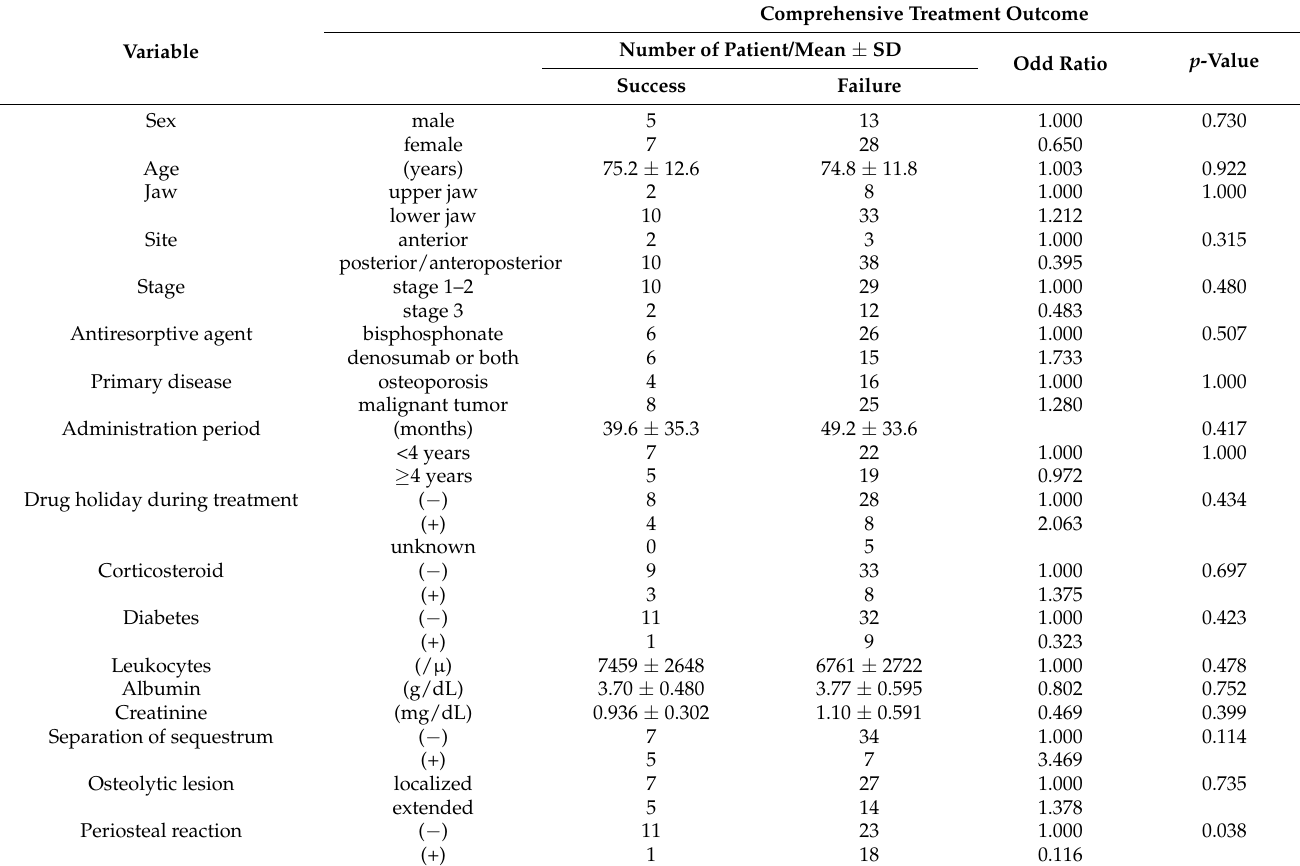
Table 4. Factors related to success or failure of